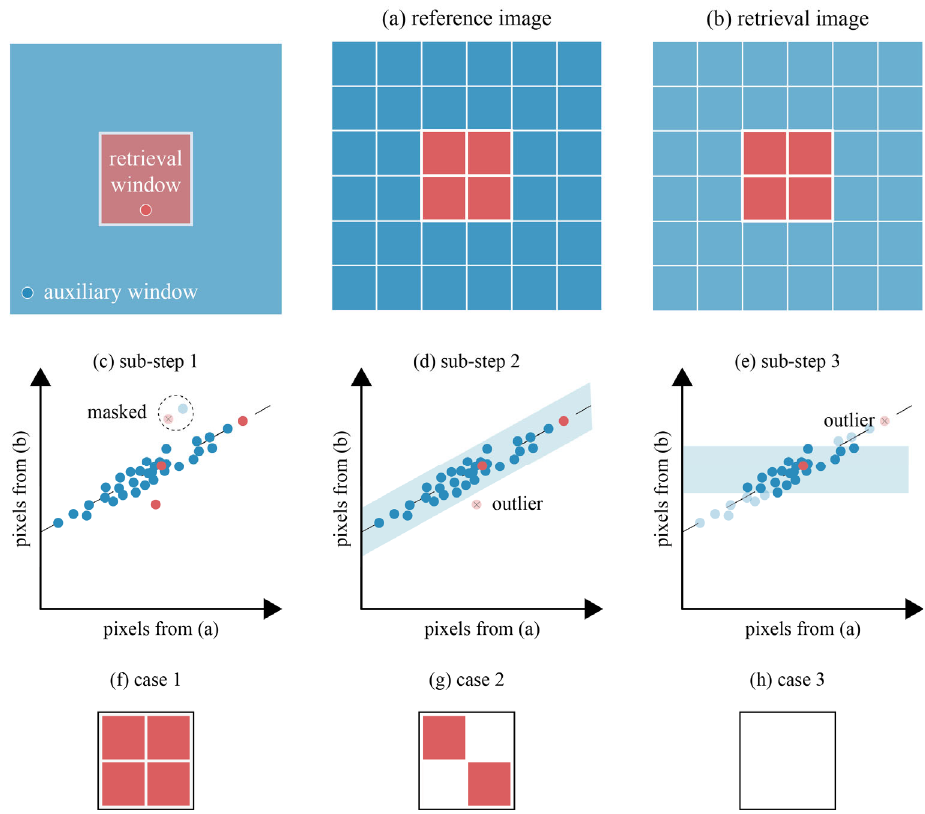
Figure 2. Window-based retrieval process. ( a ) reference image block; ( b ) retrieval image block; ( c – e ) three sub-steps; ( f – h ) three cases. (2 × 2 red window is named the retrieval window, 6 × 6 blue window is named the auxiliary window).